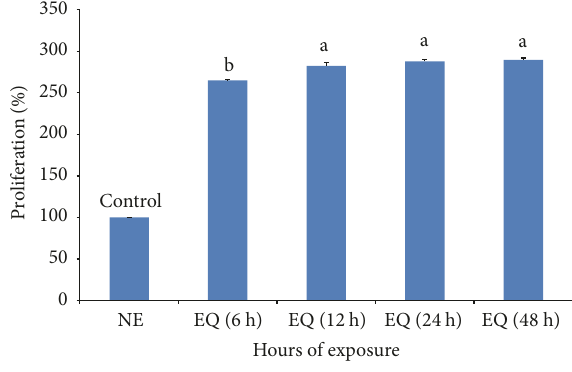
Figure 14: The effects of the exposure time on the viability of RAW 264.7 macrophage cell. Deionized water was exposed to the QELBY ceramic powder for a specified time at room temperature before preparation of DMEM. Cells were seeded in different plates for each exposure time (NE: DMEM was prepared with the water, which was not exposed; EQ: DMEM prepared with the water, which was exposed to QELBY powder for specified times). Data are mean ± SD (𝑛 = 7) . Bars with different superscript are significantly different at 𝑝 < 0.05 .